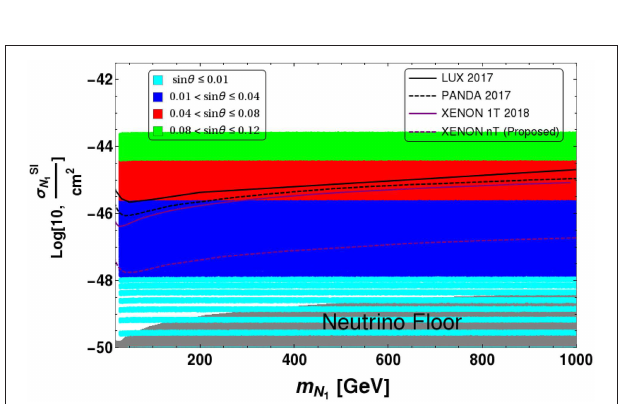
FIGURE 24 | Spin independent direct detection cross-section σ SI as a function of DM mass m N for different range of sin θ : 0.001 0.01 1 { − } (Cyan), 0.01 0.04 (Blue), 0.04 0.08 (red), and 0.08 0.12 (Green). The { − } { − } { − } direct search limits from LUX, PANDA, XENON1T are shown while that of the future sensitivity of XENONnT is also